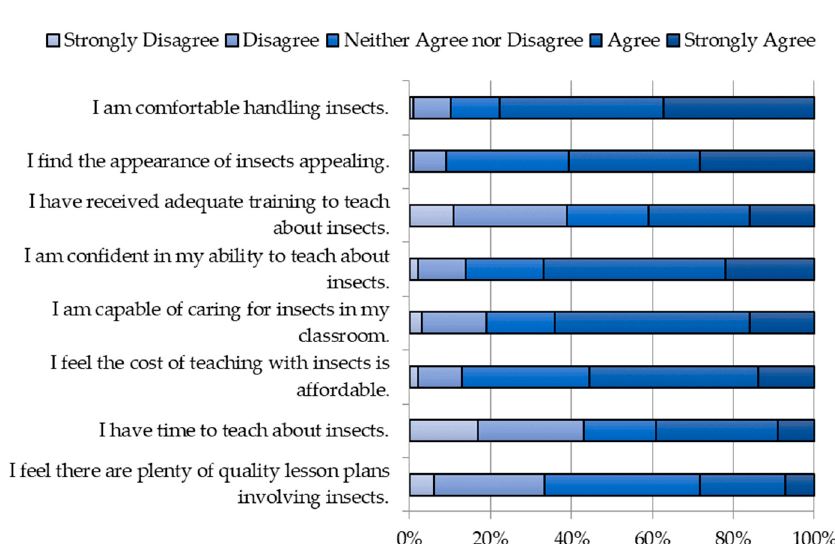
Figure 7. Teacher attitudes toward insect incorporation.